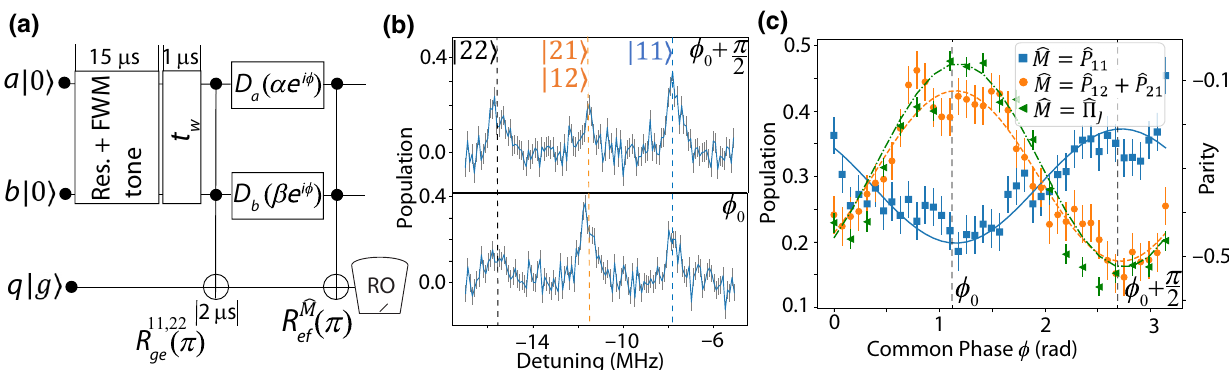
FIG. 5. The subspace-tomography protocol. (a) An example schematic for tomography in subspace S = span {| 11 (cid:2) , | 22 (cid:2)} . Photon- number-selective transmon π pulses (2- µ s-long Gaussian) are applied to isolate the two Fock components in the | e (cid:2) manifold. Cavity displacement pulses are then applied to induce interference, followed by mapping an observable ˆ M (e.g., the joint parity) to | f (cid:2) . (b) Spectroscopy of the | e (cid:2) - | f (cid:2) transition of the transmon after the cavity displacements ˆ D a ( | α | e i φ ) and ˆ D b ( | β | e i φ ) in (a) with two different displacement phases φ = φ 0 and φ 0 + π/ 2, where φ 0 is chosen to minimize the ˆ M = ˆ P 11 measurement; thus φ 0 + π/ 2 will maximize it. The difference in photon-number distribution in the two cases demonstrates the presence of interference. The | 21 (cid:2) and | 12 (cid:2) peaks overlap to appear as a single peak due to the approximately matched dispersive shift of the | e (cid:2) - | f (cid:2) transmon transition. Note that the y axis represents the relative fraction of population within the subspace S . (c) The population of | 11 (cid:2) (blue), the sum of the populations of | 21 (cid:2) and | 12 (cid:2) (orange), and the photon-number parity of the displaced state in the | e (cid:2) manifold (green), all being examples of a general measurement operator ˆ M , measured as a function of the common displacement phase φ . All fit curves correspond to the scaled √ ρ ρ = 0.63 e 0.84 i coherence element ρ 11,22 / 11 22